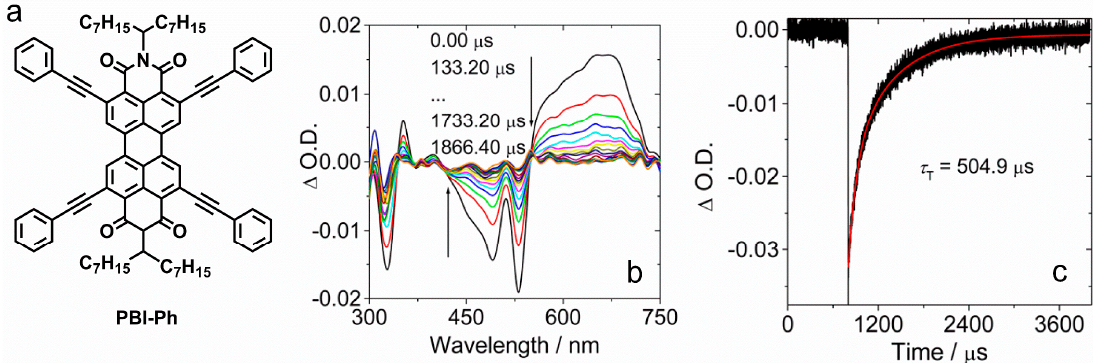
Figure 25. ( a ) Molecular structure of PBI-Ph. ( b ) Nanosecond transient absorption spectra of PBI-Ph. ( c ) Decay curves of PBI-Ph at 532 nm (black line: experimental spectrum, red line: fitting result). λ ex = 530 nm, c = 1.0 × 10 − 5 M in deaerated toluene; 20 °C. Reproduced with permission from reference